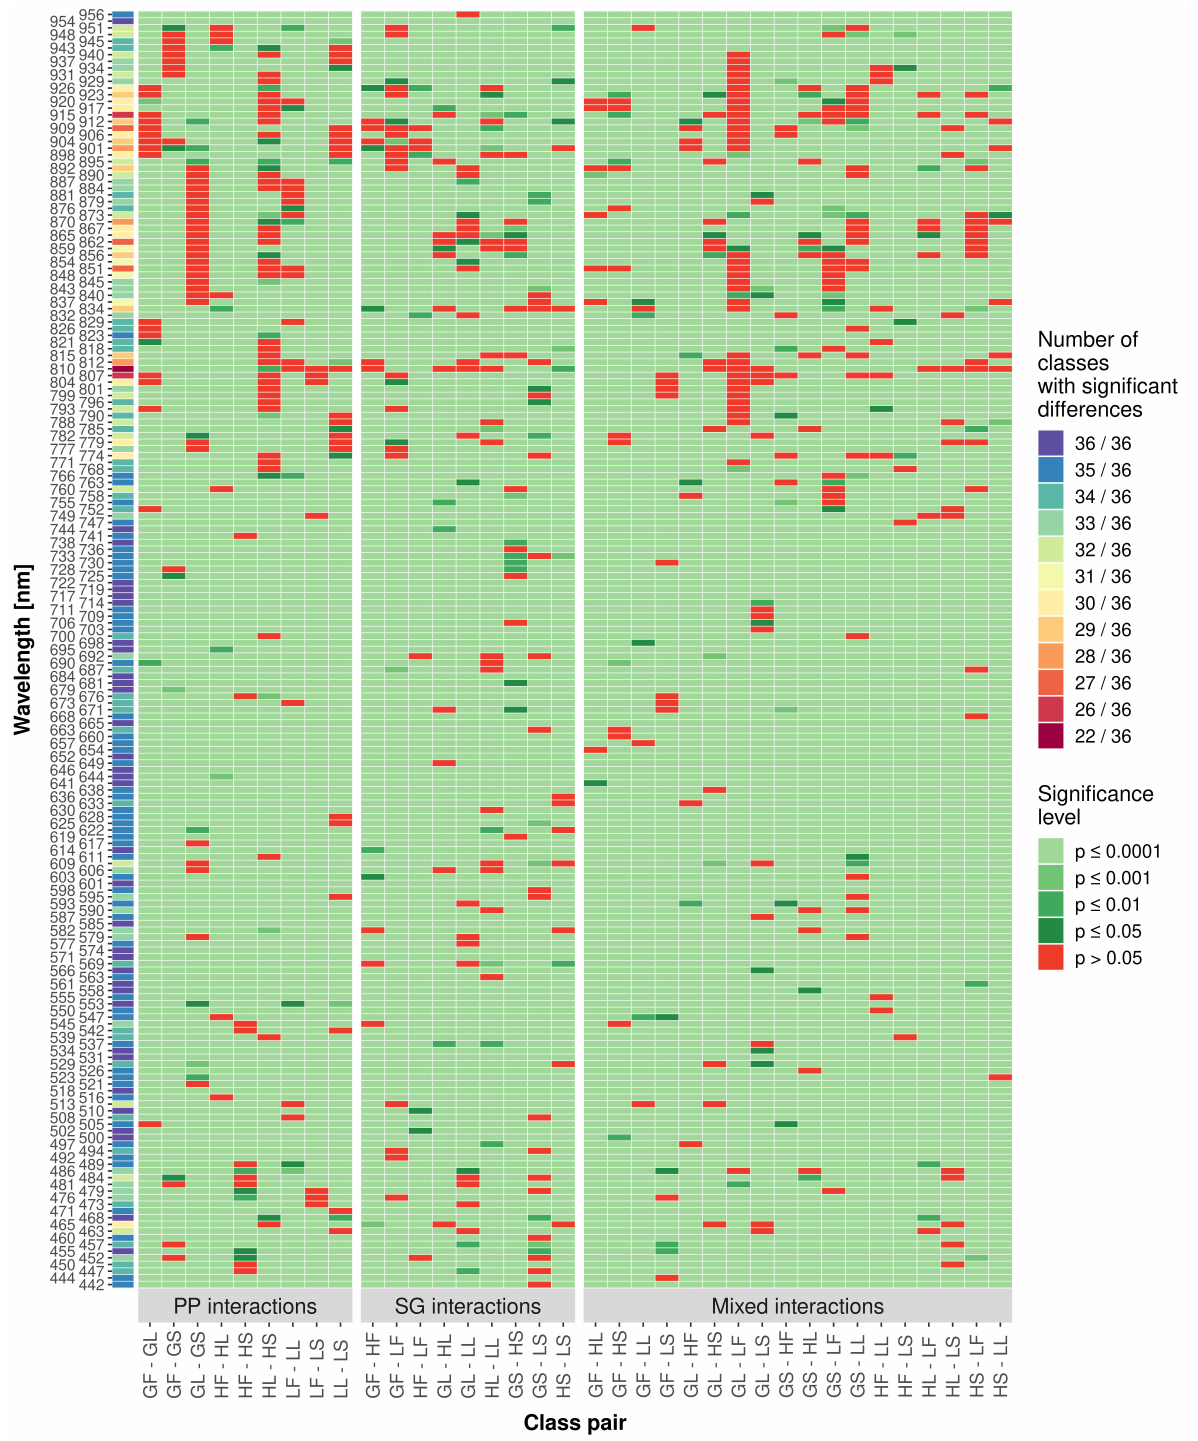
Figure 8. ANOVA followed by a Tukey–Kramer test of the dataset used for training and validation showing the significance level for class pair differences for each predictor in the main panel. On the left, colors indicating the number of class pair occurrences with significant differences ( p ≤ 0.05) are shown. First character: G = grass, H = herb, L = legume. Second character: F = flower, L = leaf, S = stem. SG = species group, PP = plant